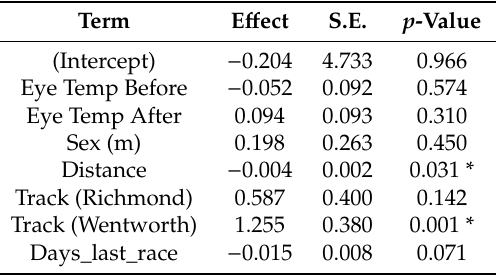
Table 5. Summary of a negative binomial linear regression model of BIA during stir-up (immediately before racing). Increasing race distance had a negative e ff ect on the frequency of aroused behaviours. More aroused behaviours were observed at the Wentworth Park track than at the Gosford track. S.E. = standard